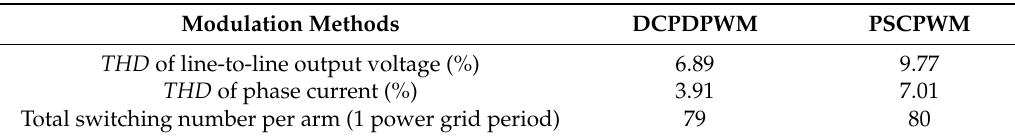
Table 2. Comparison of simulation results between DCPDPWM and PSCPWM methods with the circulating current harmonics cancellation scheme. THD : total harmonic distortion.